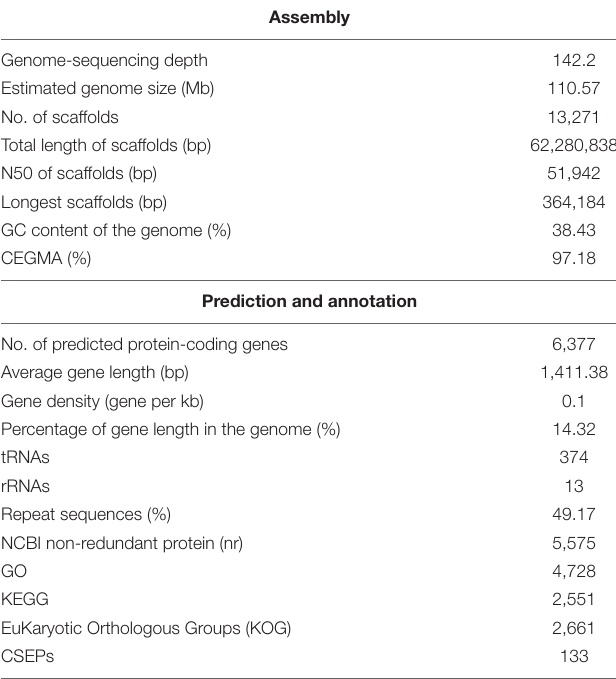
TABLE 1 | Summary of genome assembly and annotation for Oidium heveae